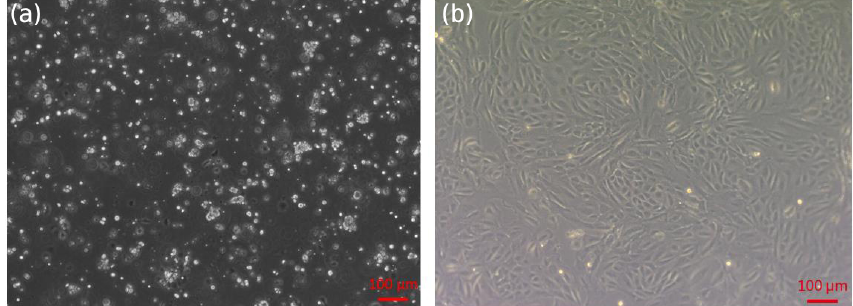
Figure 1. Isolation of sheep EECs. (a) Primary cells isolated from the epididymis of 12-month-old sheep. (b) First-passage monolayer cells reached confluency after 2–3d of culture.